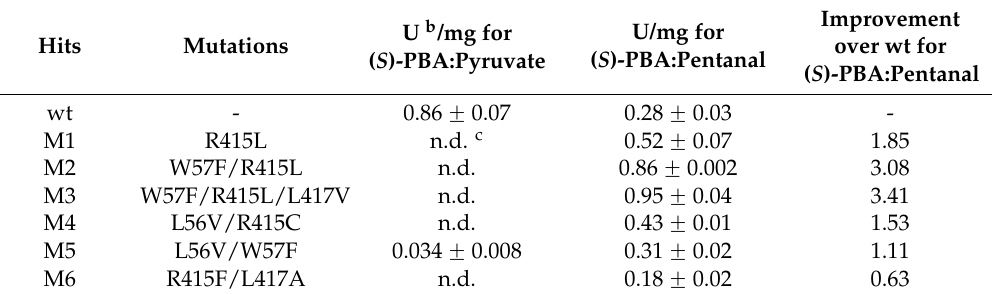
Table 1. Analysis of the initial hits after larger scale production and purification a . ( S )-PBA, ( S